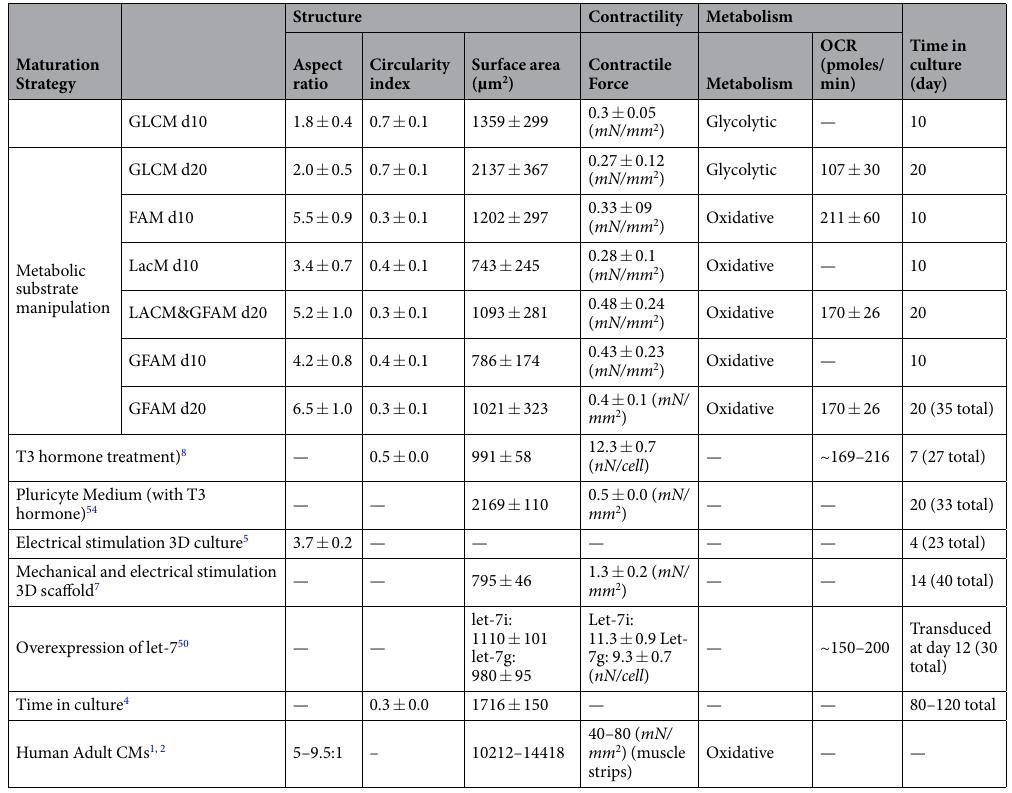
Table 1. Comparison of structural, functional and metabolic features of hPSC-CMs cultured in GLCM, LACM and GFAM and other approaches reported in the literature with human adult CMs. Abbreviations: OCR- Oxygen Consumption Rate; T3 – Triiodothyronine; (—) – Non determined or non reported in the literature; (~) –